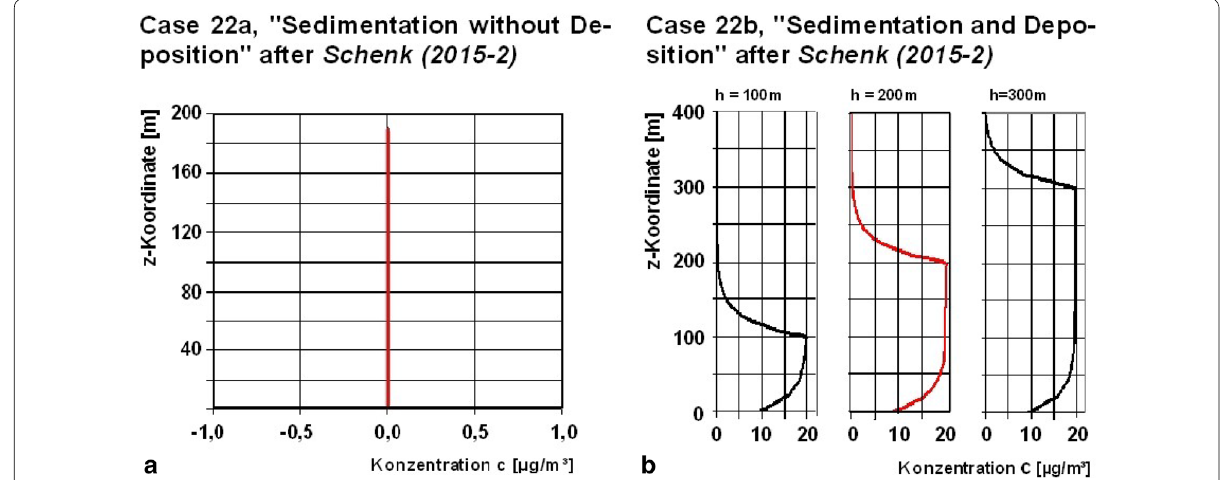
Fig. 2 Concentration distributions for sedimentation with and without deposition, Schenk